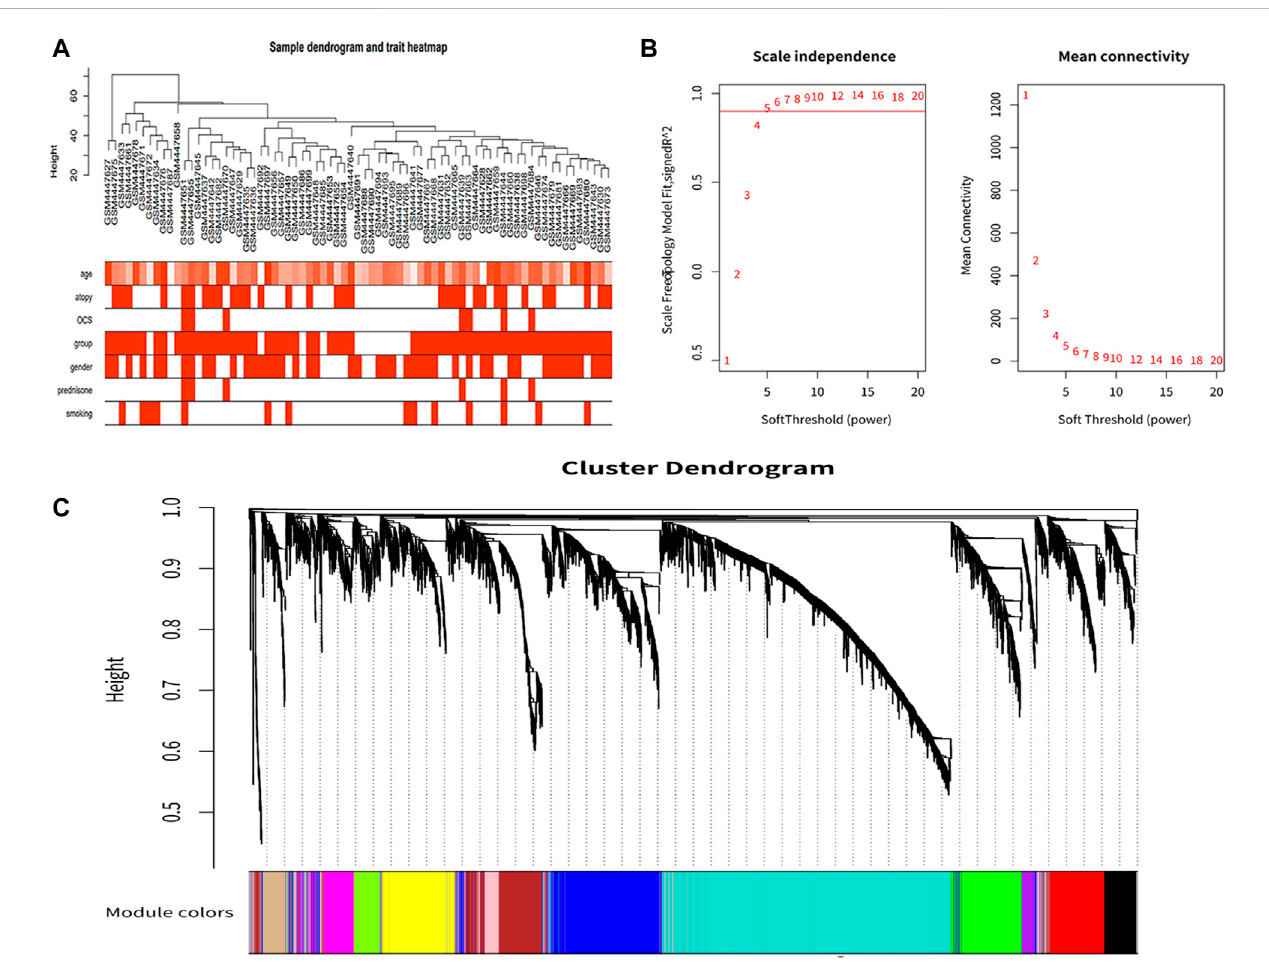
FIGURE 1 Co-expression network construction. (A) Sample clustering dendrogram based on Euclidean distance. (B) Analysis of network topology for various soft- thresholding powers. With a scale-free topological criterion > 0.9, 5 was chosen as the fi ttest power value. (C) Clustering dendrogram of genes, with dissimilarity based on the topological overlap, together with assigned module